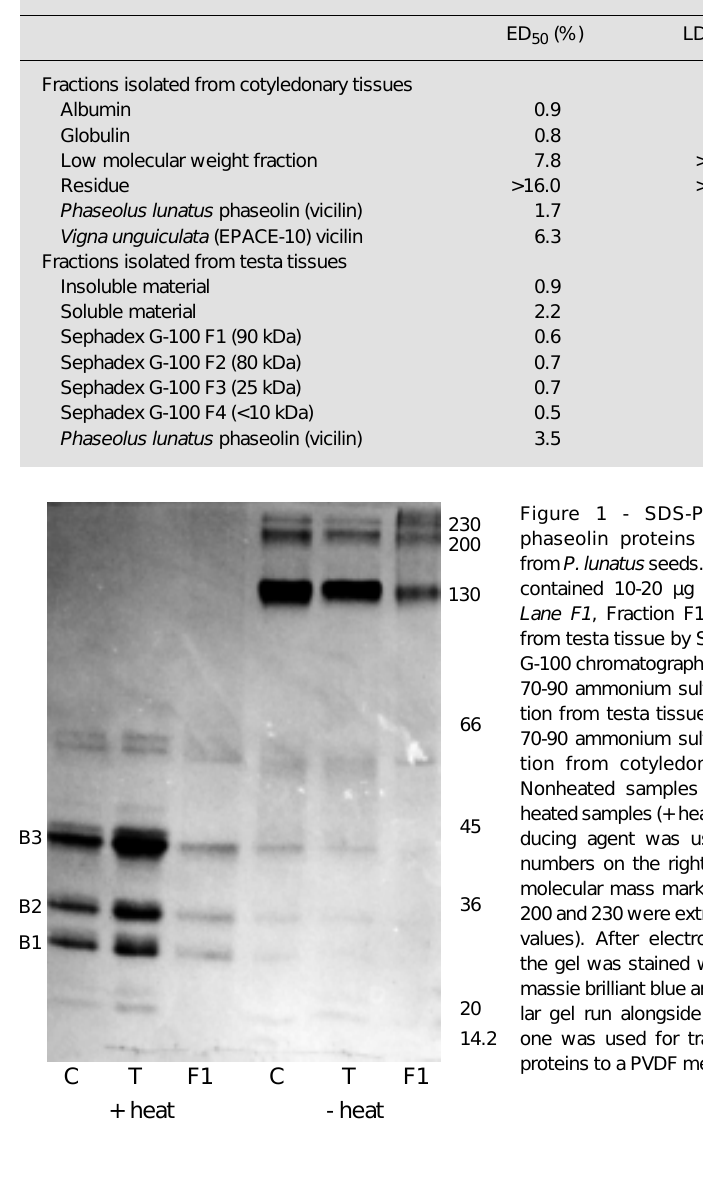
Table 3 - Effect of the addition of several protein fractions to the diet of C. maculatus .